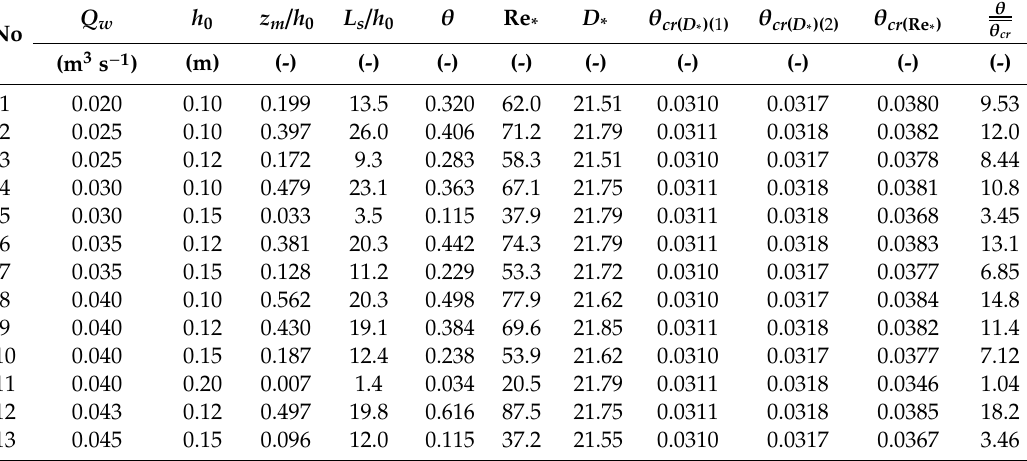
Table A3. Summary table of calculation results—variant III of flume development; stone weir with reinforcement; “live-bed”